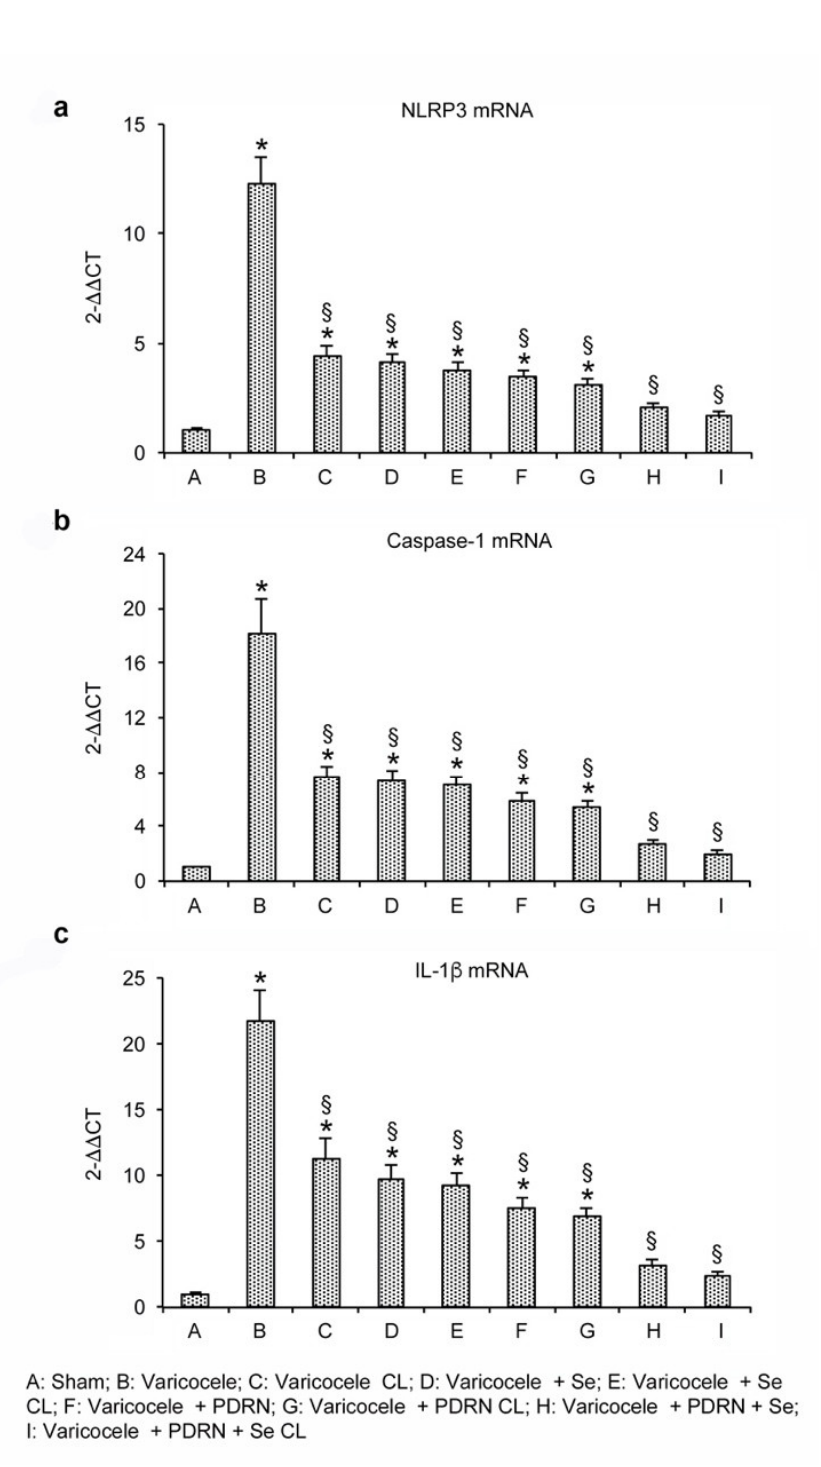
Figure 1. Real-time PCR analysis for NLRP3 ( a ), caspase-1 ( b ) and IL-1 β ( c ) in the testes from rats of sham, varicocele, varicocele contralateral, varicocele plus Se (0.4 mg/kg/day i.p.), varicocele plus Se contralateral, varicocele plus PDRN (8 mg/kg/day i.p.), varicocele contralateral plus PDRN, varicocele plus Se plus PDRN, varicocele contralateral plus Se plus PDRN groups. * = p < 0.05 versus sham; § = p < 0.05 versus varicocele. Bars represent the mean ± SE of 7 experiments.